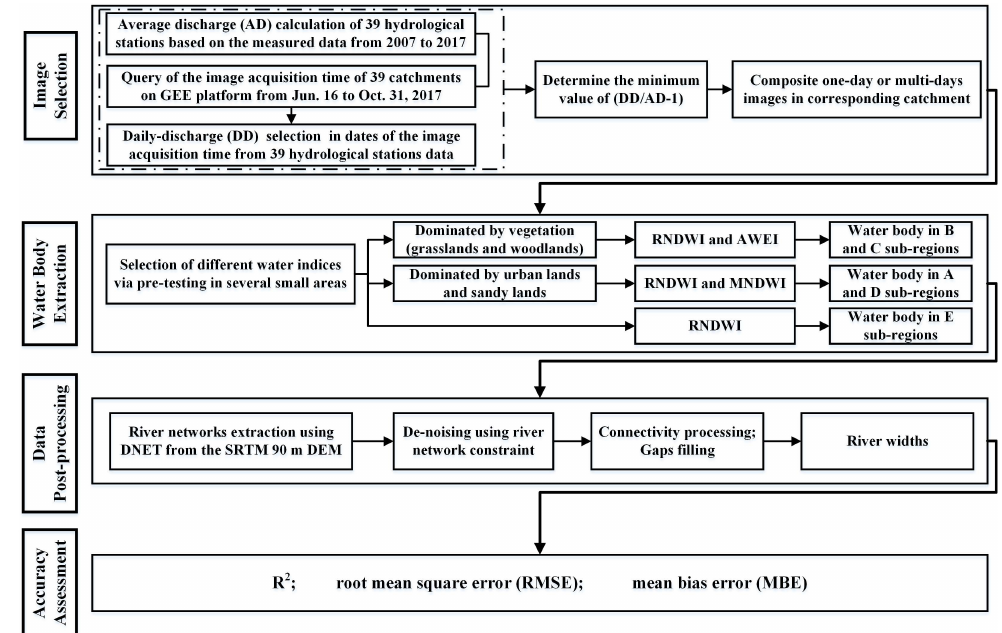
Figure 2. The flow chart of the